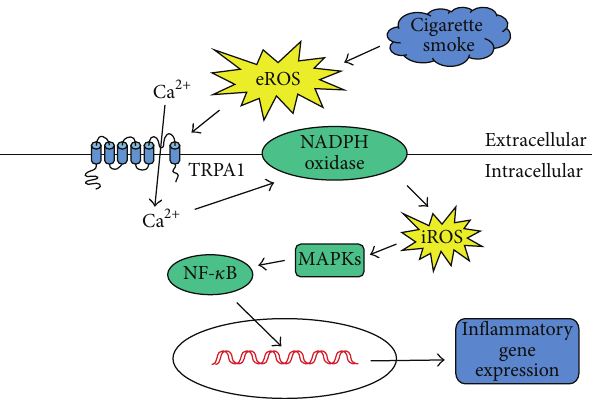
Figure 9: The proposed mechanism of TRPA1 activation for the induction of IL-8 by cigarette smoke (CS). As shown, exposure to CS initially causes an increase in the extracellular level of reactive oxygenspecies(ROS),whichinturnactivateslungepithelialTRPA1; this leads to the promotion of a Ca 2+ influx. The increase in the intracellular level of Ca 2+ in lung epithelial cells then contributes to the activation of NADPH oxidase, which in turn results in an elevation of the intracellular level of ROS and this then activates the mitogen-activatedproteinkinases(MAPKs)/nuclearfactor- 𝜅 B(NF- 𝜅 B) signaling pathway allowing induction of IL-8.